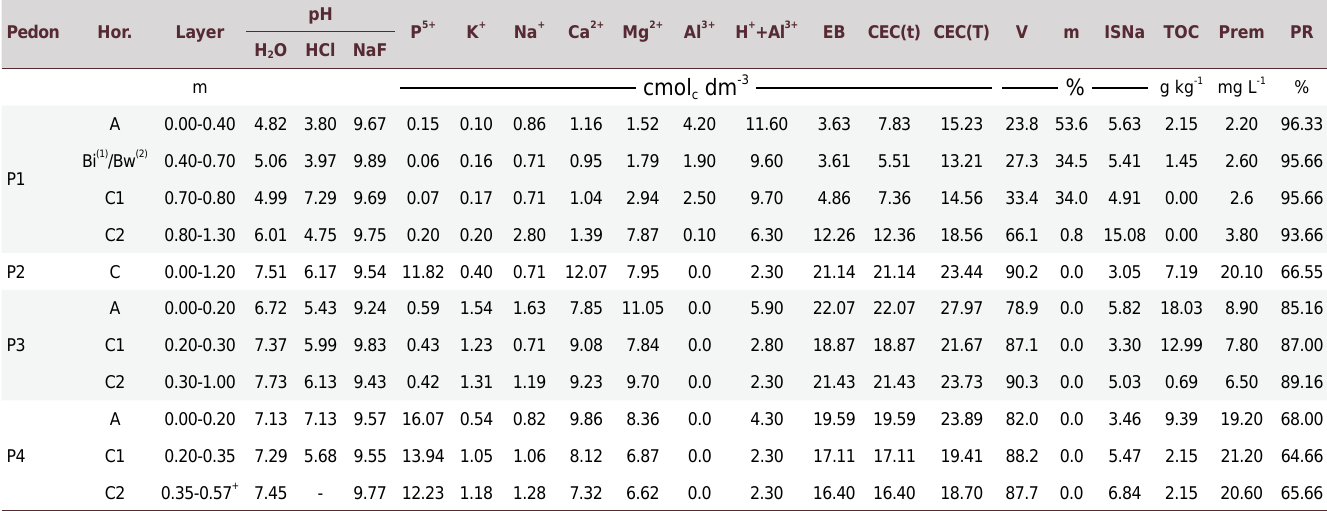
Table 2. Chemical properties of Trindade Island soils Pedon Hor.